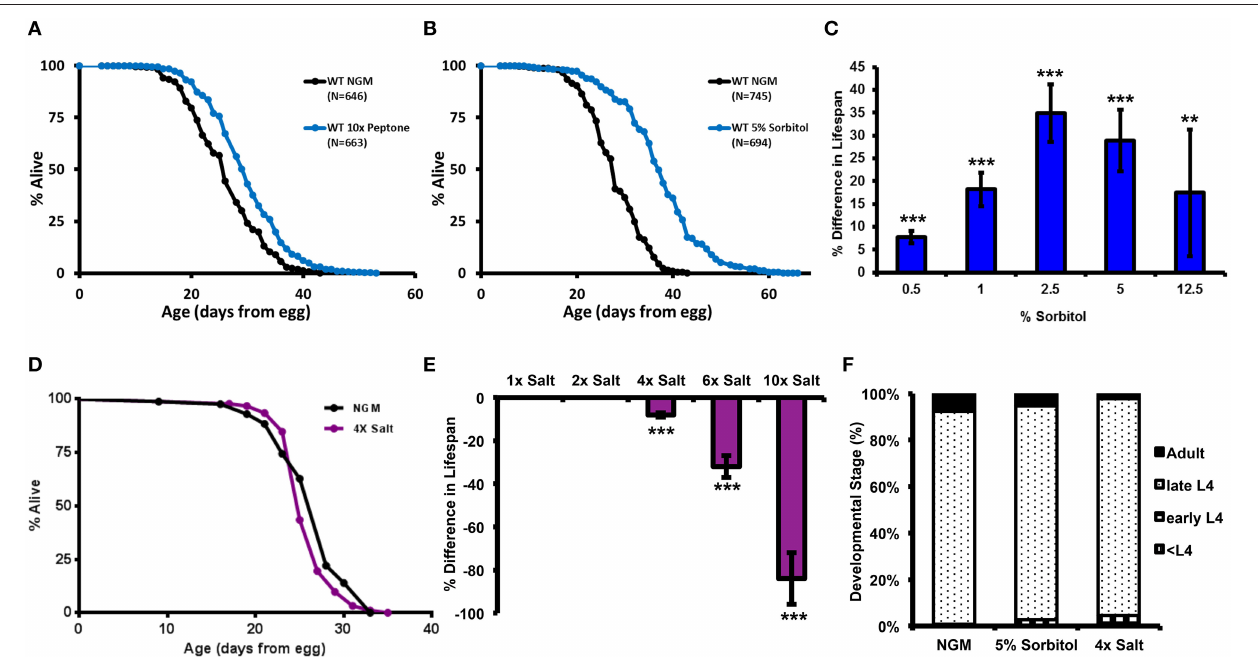
FIGURE 1 | Effect of Peptone, Sorbitol, and NaCl on lifespan in C. elegans . Lifespan is increased by addition of (A) a 10-fold higher concentration of peptone (2.5g/L) or (B) 5% sorbitol to the nematode growth medium (NGM). (C) Effect of sorbitol on lifespan as a dose response. Addition of sorbitol to NGM at 0.5, 1, 2.5, 5, or 12.5% significantly extends lifespan ( ** p < 0.01 , *** p < 0.005 , t -test). (D,E) Addition of NaCl to NGM at 4, 6, or 10 times the normal concentration significantly decreases lifespan ( *** p < 0.001 in all cases, t -test). (F) Neither 5% sorbitol nor 4X NaCl significantly delayed